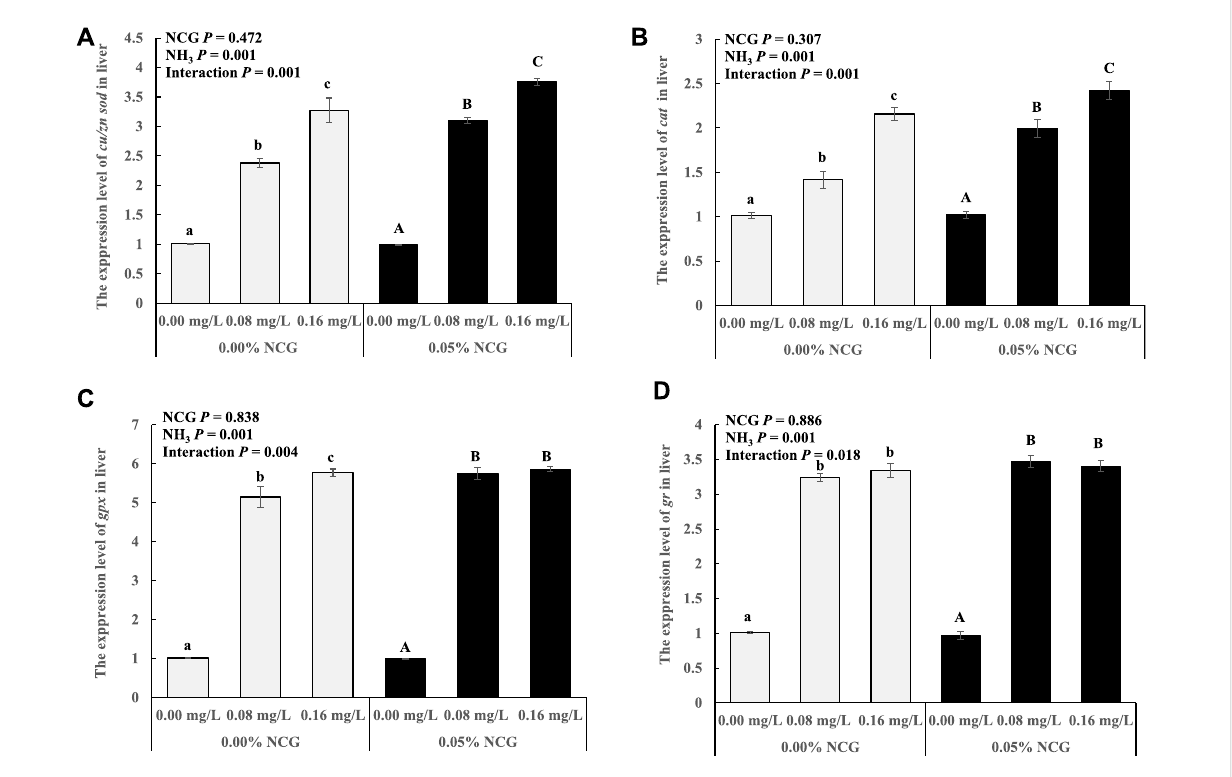
FIGURE 1 Relativeexpressionlevels ofantioxidant-related genes cu/znsod (A) , cat (B) , gpx (C) ,and gr (D) inliver.Therelativeexpressionofthetranscriptfrom qRT-PCRwascalculatedbasedonthestandardcurveandnormalizedtothe β -actin and gapdh mRNAlevel( n =3).Thedifferentlettersrepresentexisting signi fi cant differences between the three ammonia levels ( p <